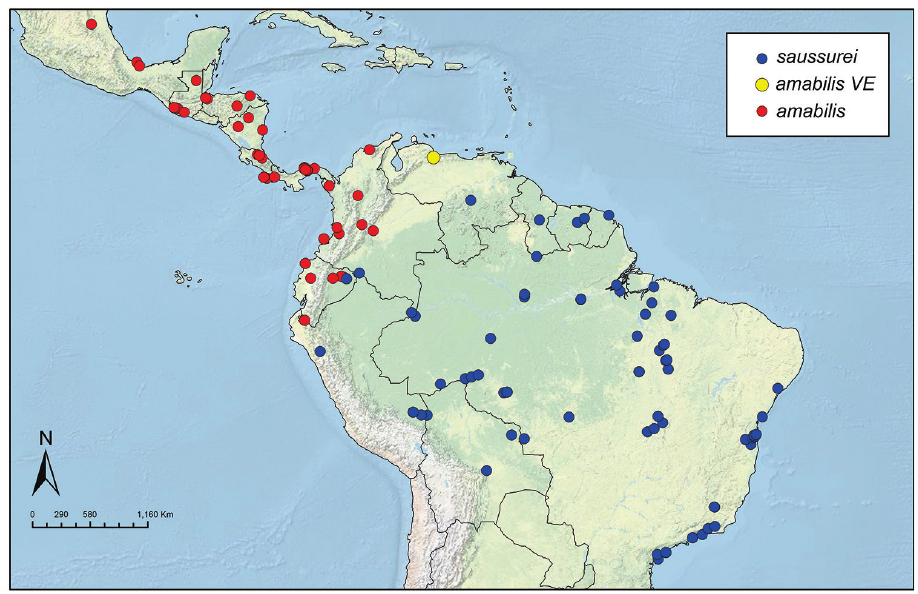
Figure 21. Distribution map of S. amabilis and S. saussurei